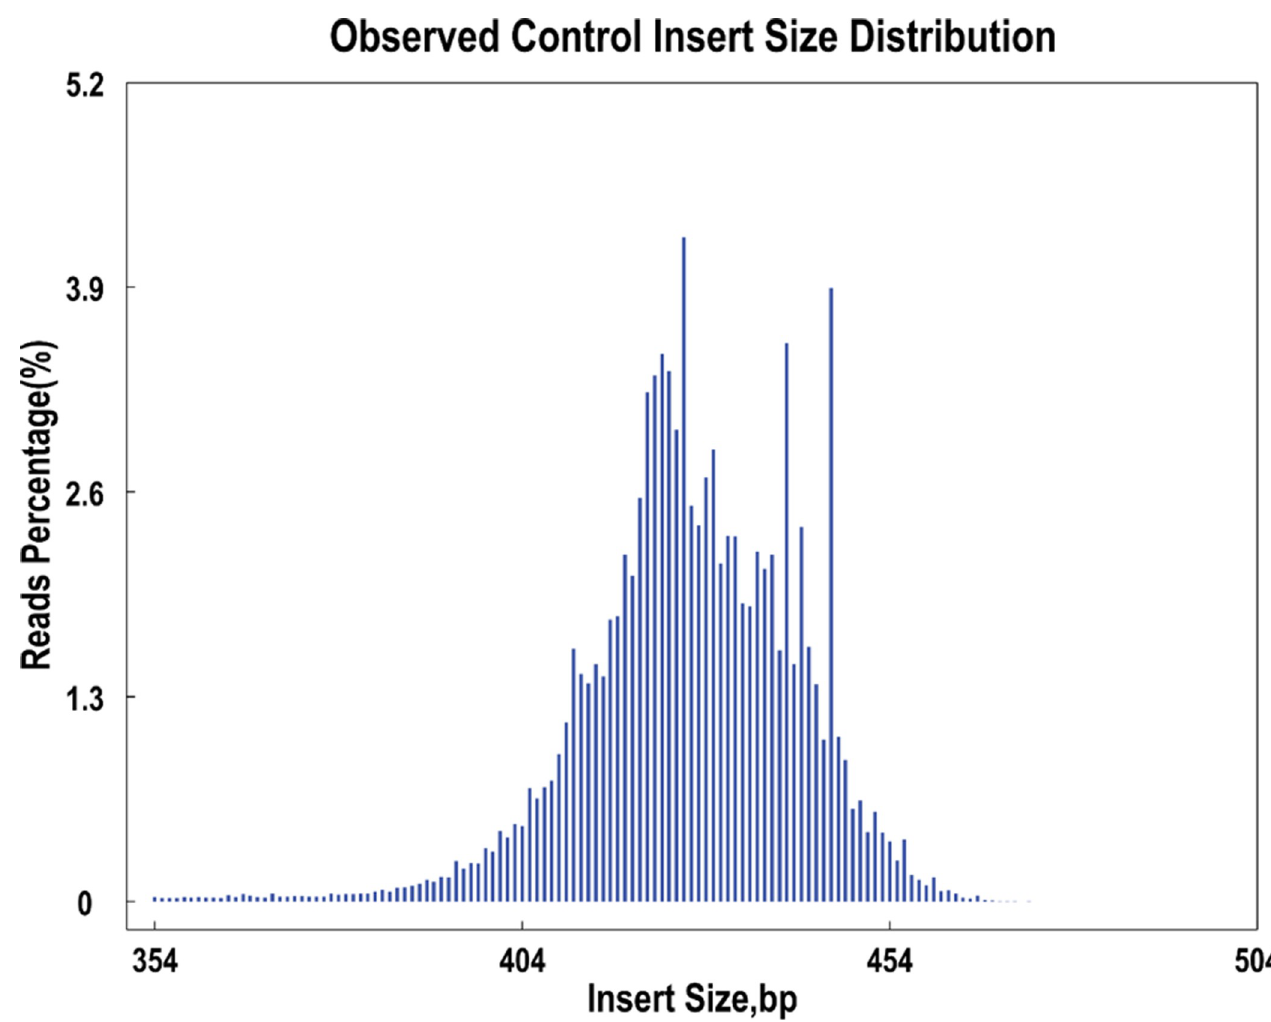
Fig 2. The length distribution of the SLAF tags. Abscissa represents the insertion fragment with different length. The ordinate represents the reads